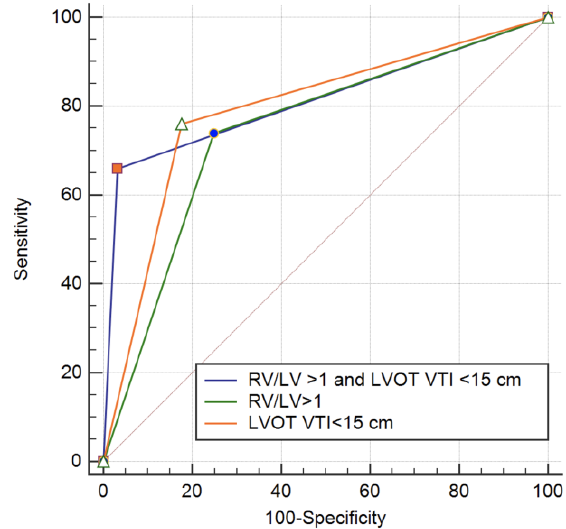
Figure 3 . ROC curves for adverse event prediction in intermediate risk PE . Figure 3. ROC curves for adverse event prediction in intermediate risk PE.